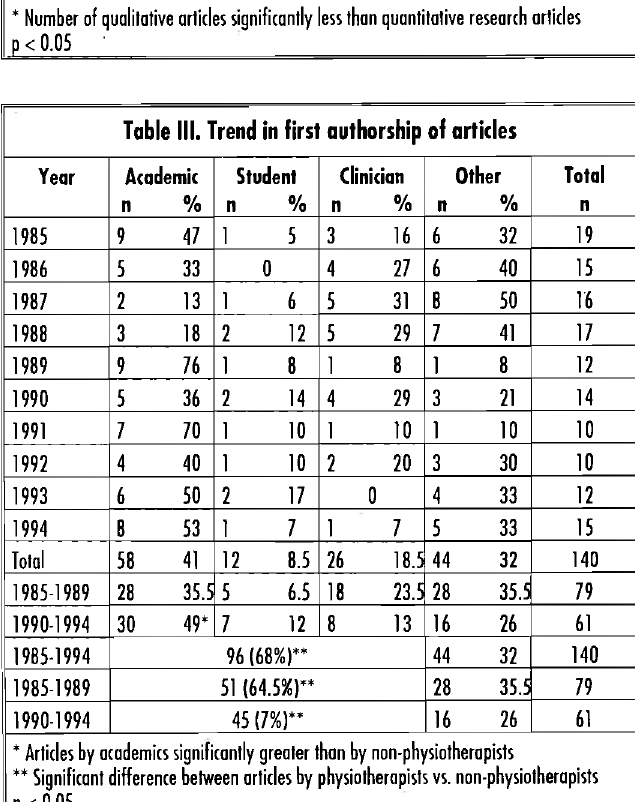
Table 1. Trend in type of